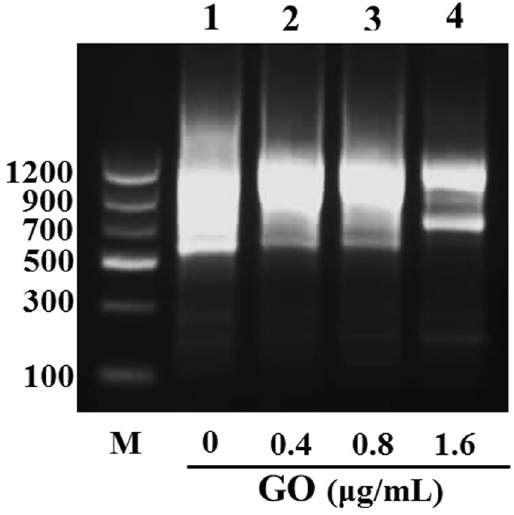
Figure 6. The effect of GO on FOXL2 gene amplification. The coding sequence of FOXL2 gene cloned to the PEGFP-N1 vector was used as the template. PCR was performed by employing an 1130 bp target sequence from PEGFP-N1 vector template. PCR products were analyzed by agarose gel electrophoresis (1.5%). Lane M is